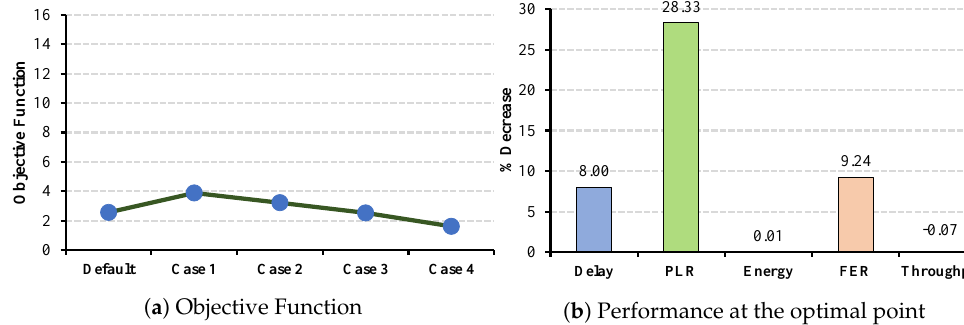
( b ) Performance at the optimal point Figure 12. EEG QoS metrics and energy consumption under CW changes for all cells.